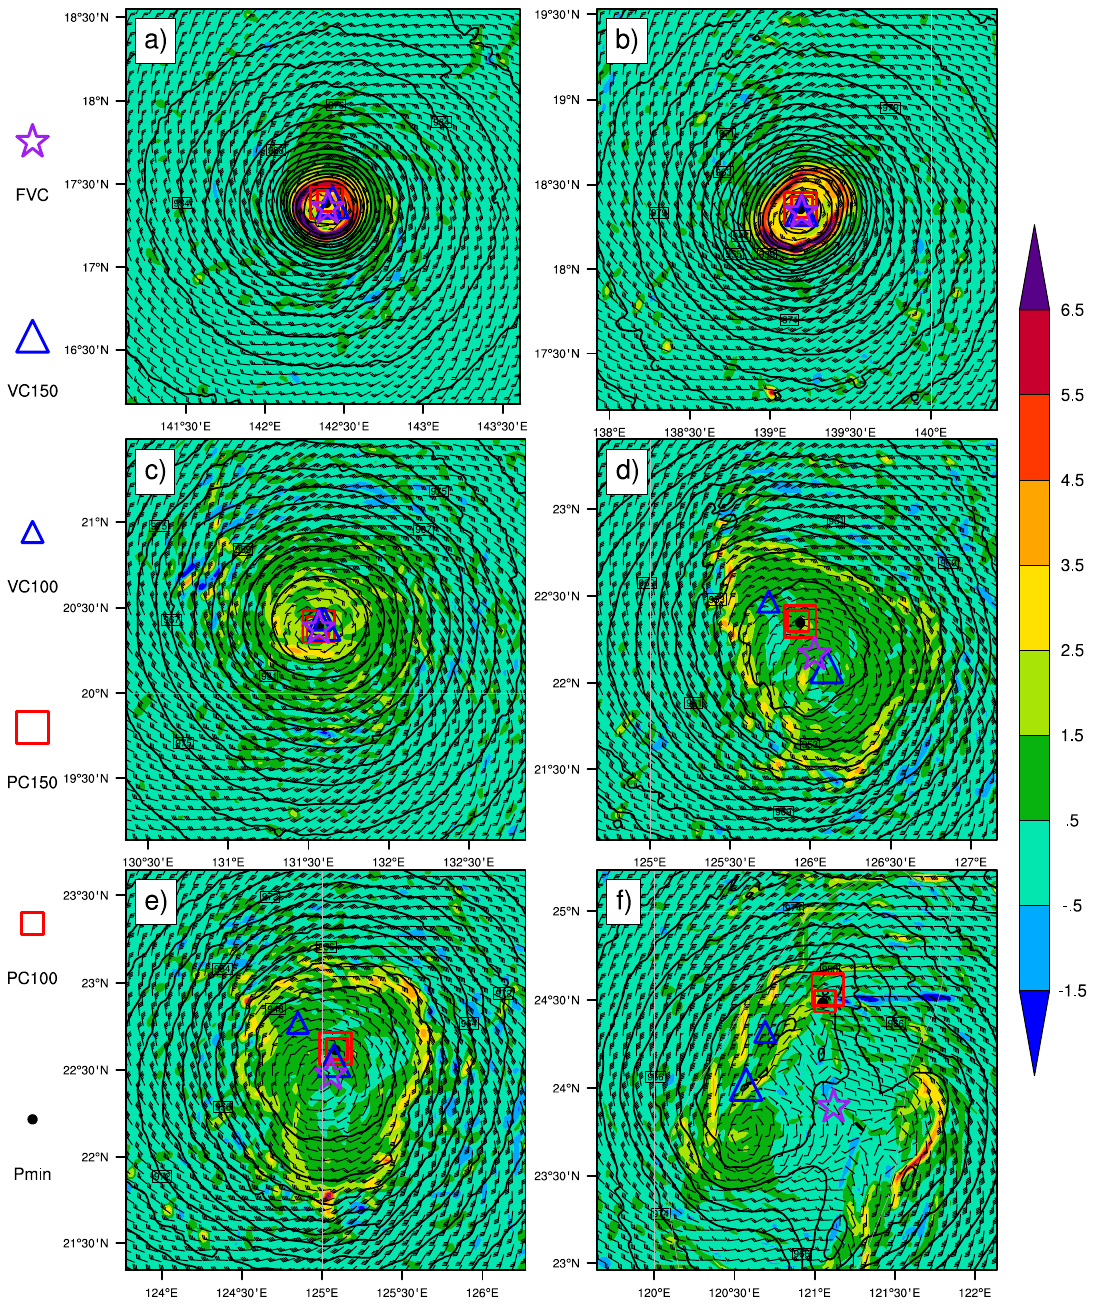
Figure 9. The horizontal structures of simulated Soudelor including the surface level pressure (black lines), vorticity (shaded) and winds (wind-bars) at 10 m above the sea level. The location of detected centers are represented by different markers displayed at left. ( a – f ) display the fields at time 0900 UTC 3, 2300 UTC 3, 1700 UTC 5, 1900 UTC 6, 0000 UTC 7, and 2100 UTC 7 August,